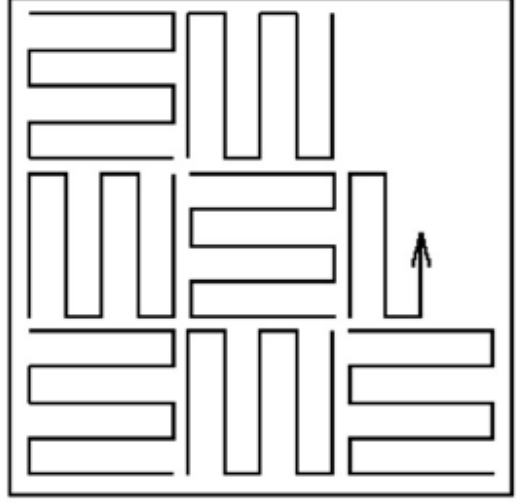
Figure 1. Chessboard strategy.